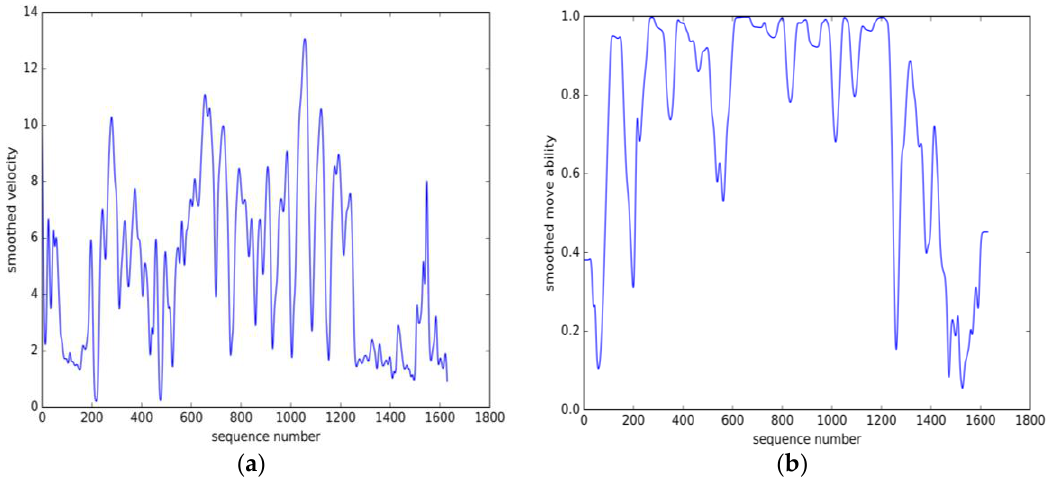
Figure 3. The velocity curve and move ability curve of a real-world track. ( a ) Smoothed velocity curve; ( b ) smoothed move ability curve.